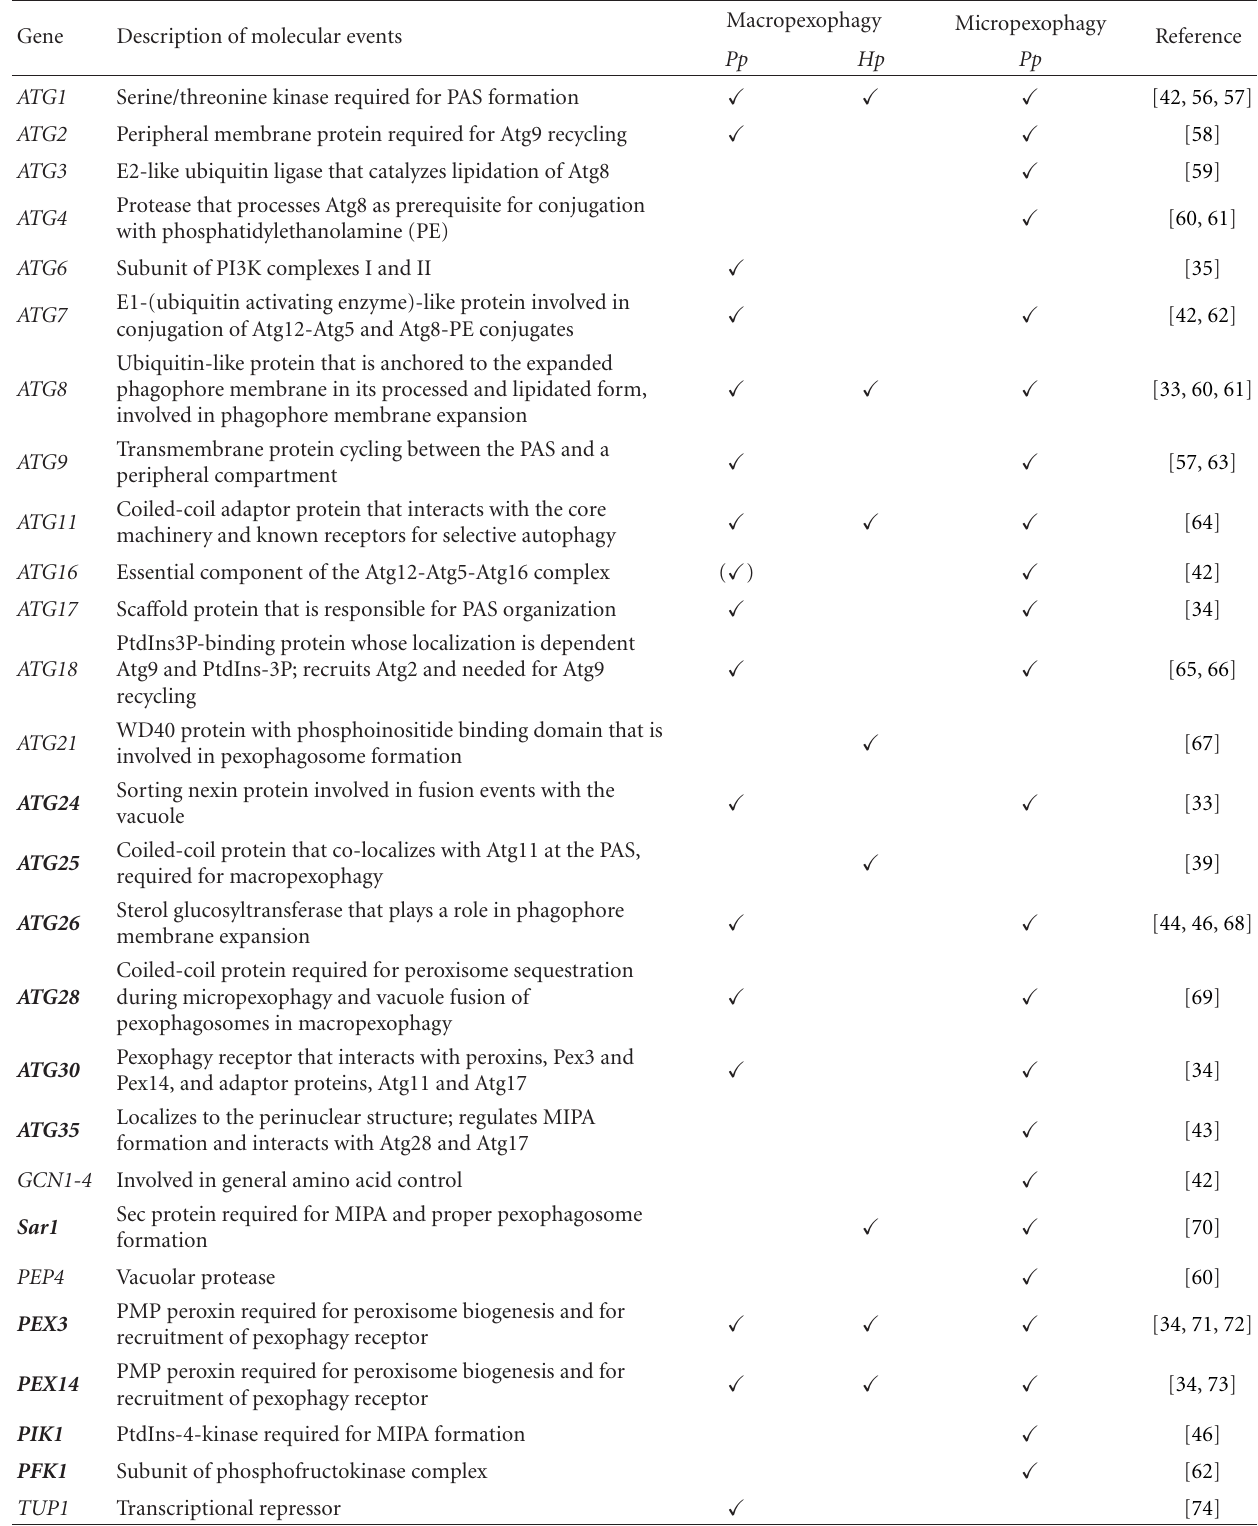
Table 1: Genes involved in macro- and micropexophagy in methylotrophic yeasts. Involvement of the respective genes in the di ff erent modes of pexophagy is indicated by check marks. Genes denoted in bold font are (by current knowledge) exclusively involved in pexophagy, but not in other autophagy pathways. Genes denoted in regular font represent components of the core machinery involved in di ff erent autophagy pathways in the methylotrophic yeasts Pichia pastoris (Pp) and Hansenula polymorpha (Hp) . Empty spaces and parentheses depict the current lack of conclusive evidence. Table adapted from Sakai et al .